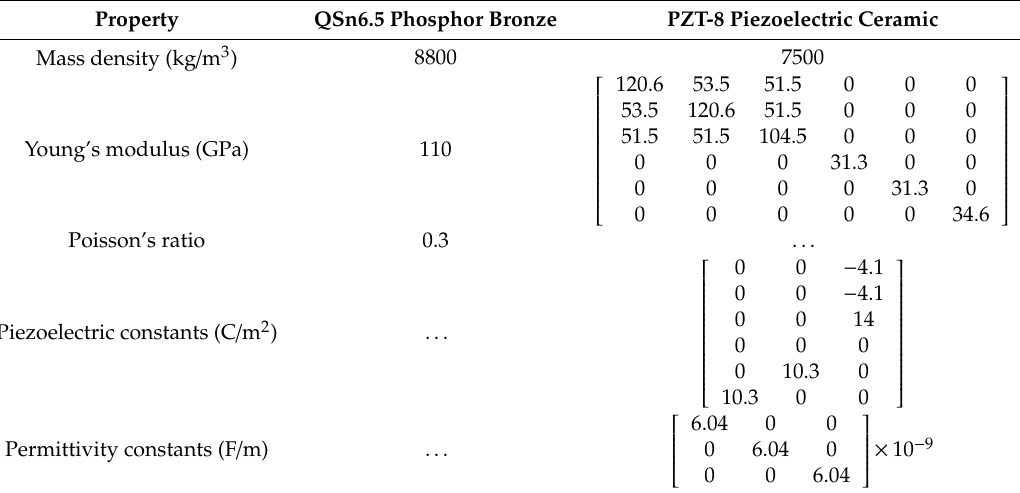
Figure 4. ( a ) B 011 working mode of 70HA and ( b ) simulation curves of the stator vibration parameters of 70HA. Table 1. Properties of the stator materials.